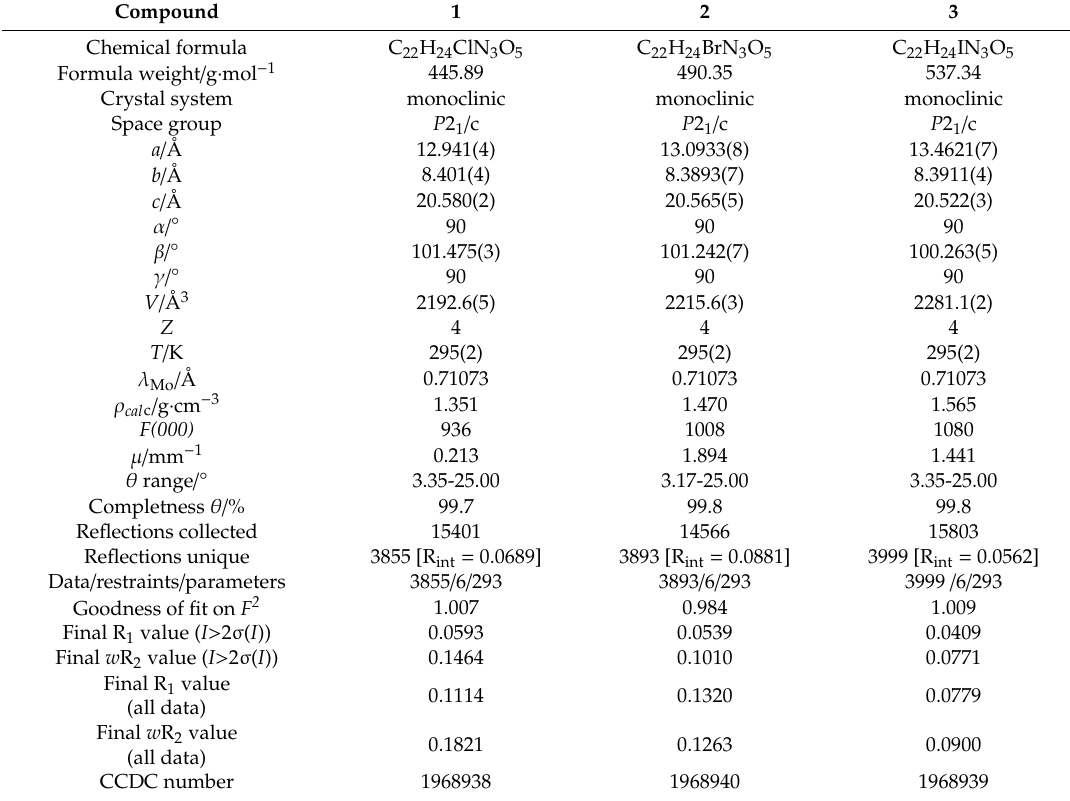
Table 2. Hydrogen bonds geometry for compounds 1 – 3. Table 1. Crystal data and structure refinement parameters for compounds 1 – 3 .